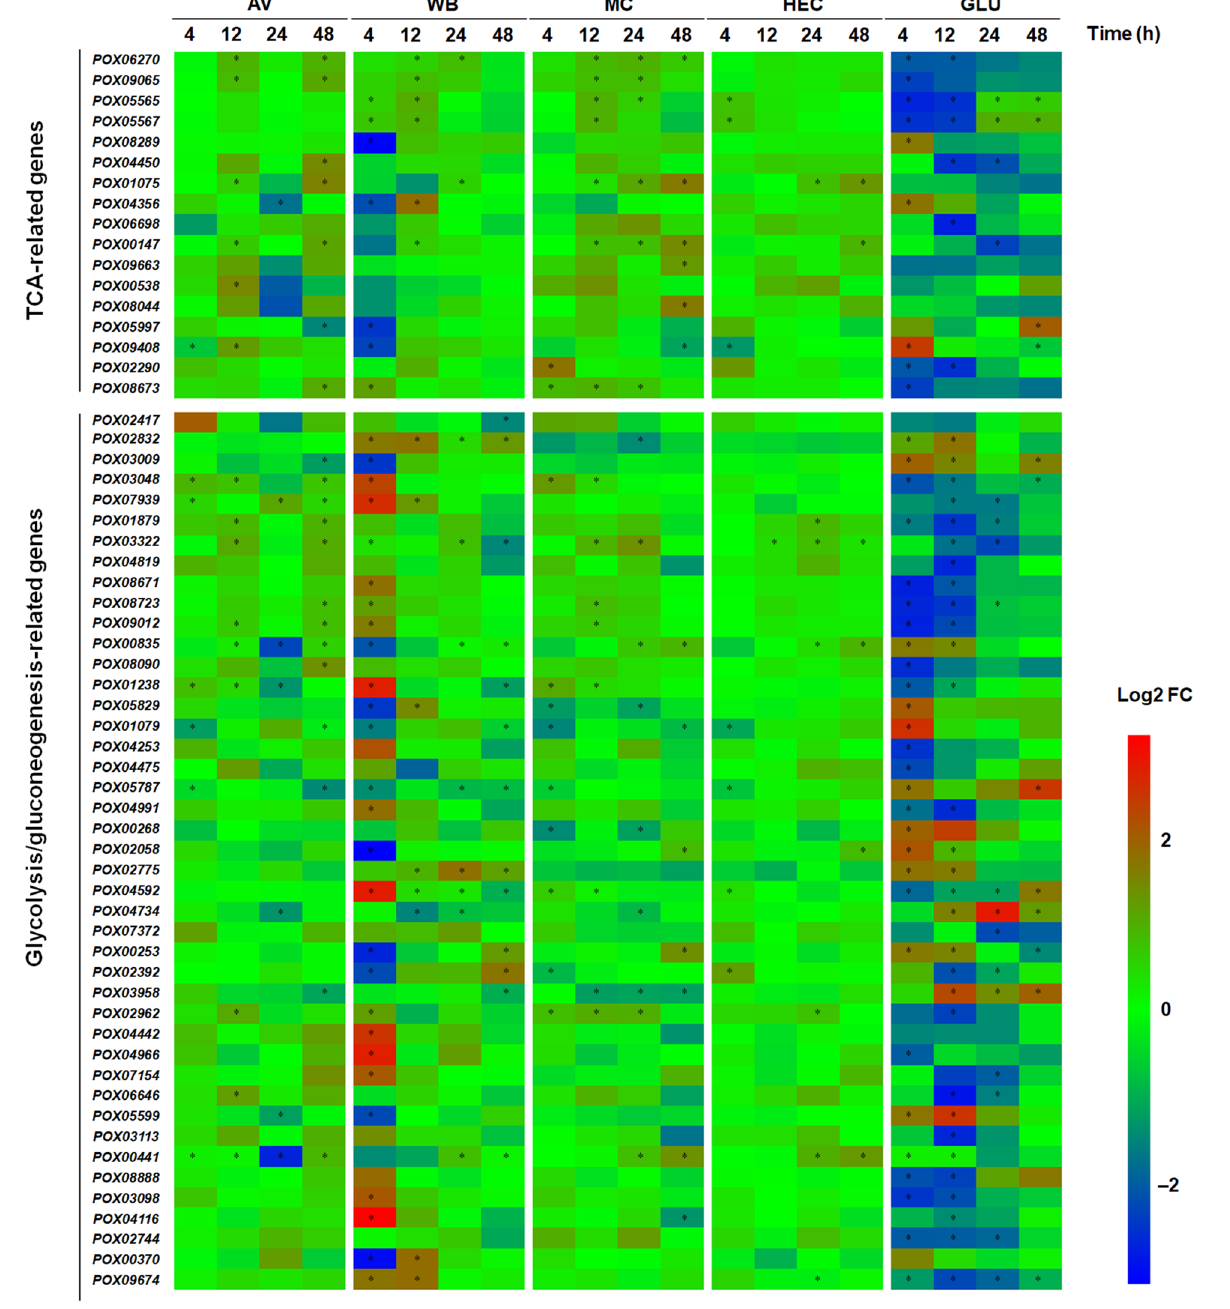
FIGURE 5 | Heatmap indicating transcriptional levels of DEGs involved in glycolysis/gluconeogenesis and TCA cycle in P. oxalicum on different carbon sources (AV, MC, HEC, WB, and GLU) compared with NC. ∗ represents the DEGs ( p ≤ 0.05, | log2 fold change) | ≥ 1.0). The heatmap shows the log2 fold change of each gene on different carbon sources compared with that on NC. DEGs: differentially expressed genes; AV, Avicel; MC, methyl cellulose; HEC, 2-hydroxyethyl cellulose; GLU, glucose; NC, no carbon source; TCA, tricarboxylic acid cycle; FC, fold